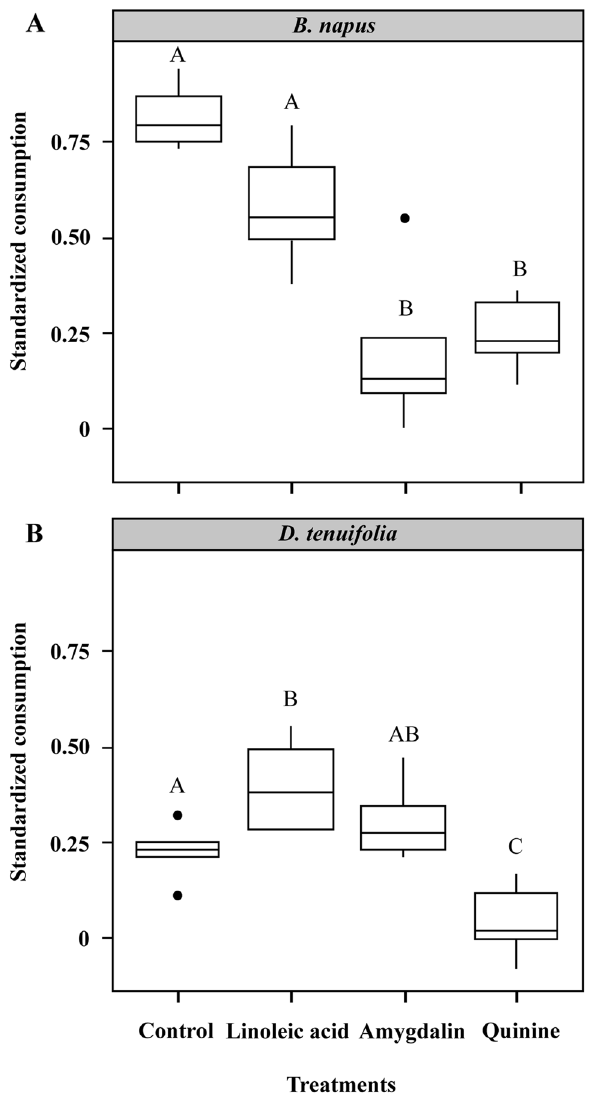
Figure 2. Effects of adulterated pollen on learned consumption preferences of nurse-aged bees. ( A ) Standardized consumption of B. napus was obtained after caged bees experienced B. napus pollen unadulterated (control) or adulterated with a phagostimulant (linoleic acid) or a deterrent substance (amygdalin or quinine). ( B ) Similarly, standardized consumption of D. tenuifolia was obtained after caged bees experienced D. tenuifolia pollen adulterated with linoleic acid, amygdalin, quinine, or unadulterated (control). The box plots show medians, quartiles, and 5th and 95th percentiles. Different letters indicate significant differences between treatments ( P <